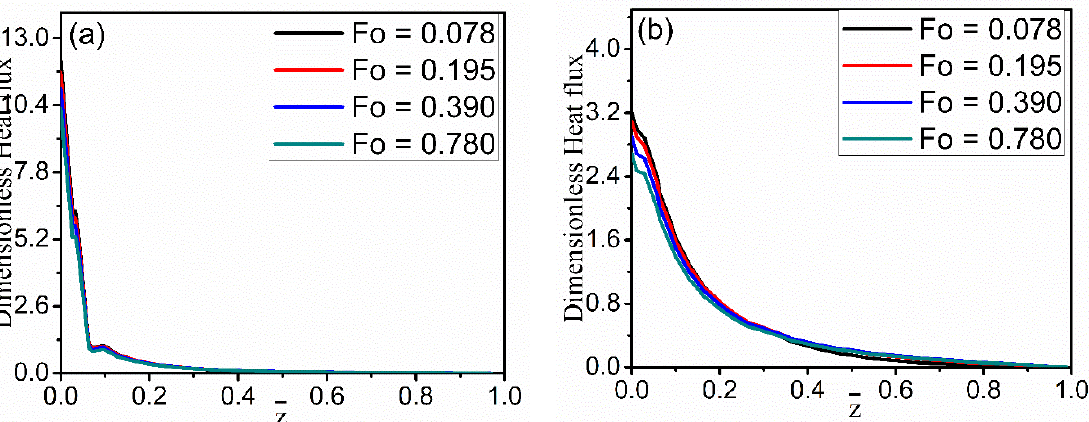
Figure 6. Changes in the dimensionless heat flux (without the nickel coating) along the fiber-axis direction at ( a ) r̅ = 0.19, ( b ) r̅ = 0.26.